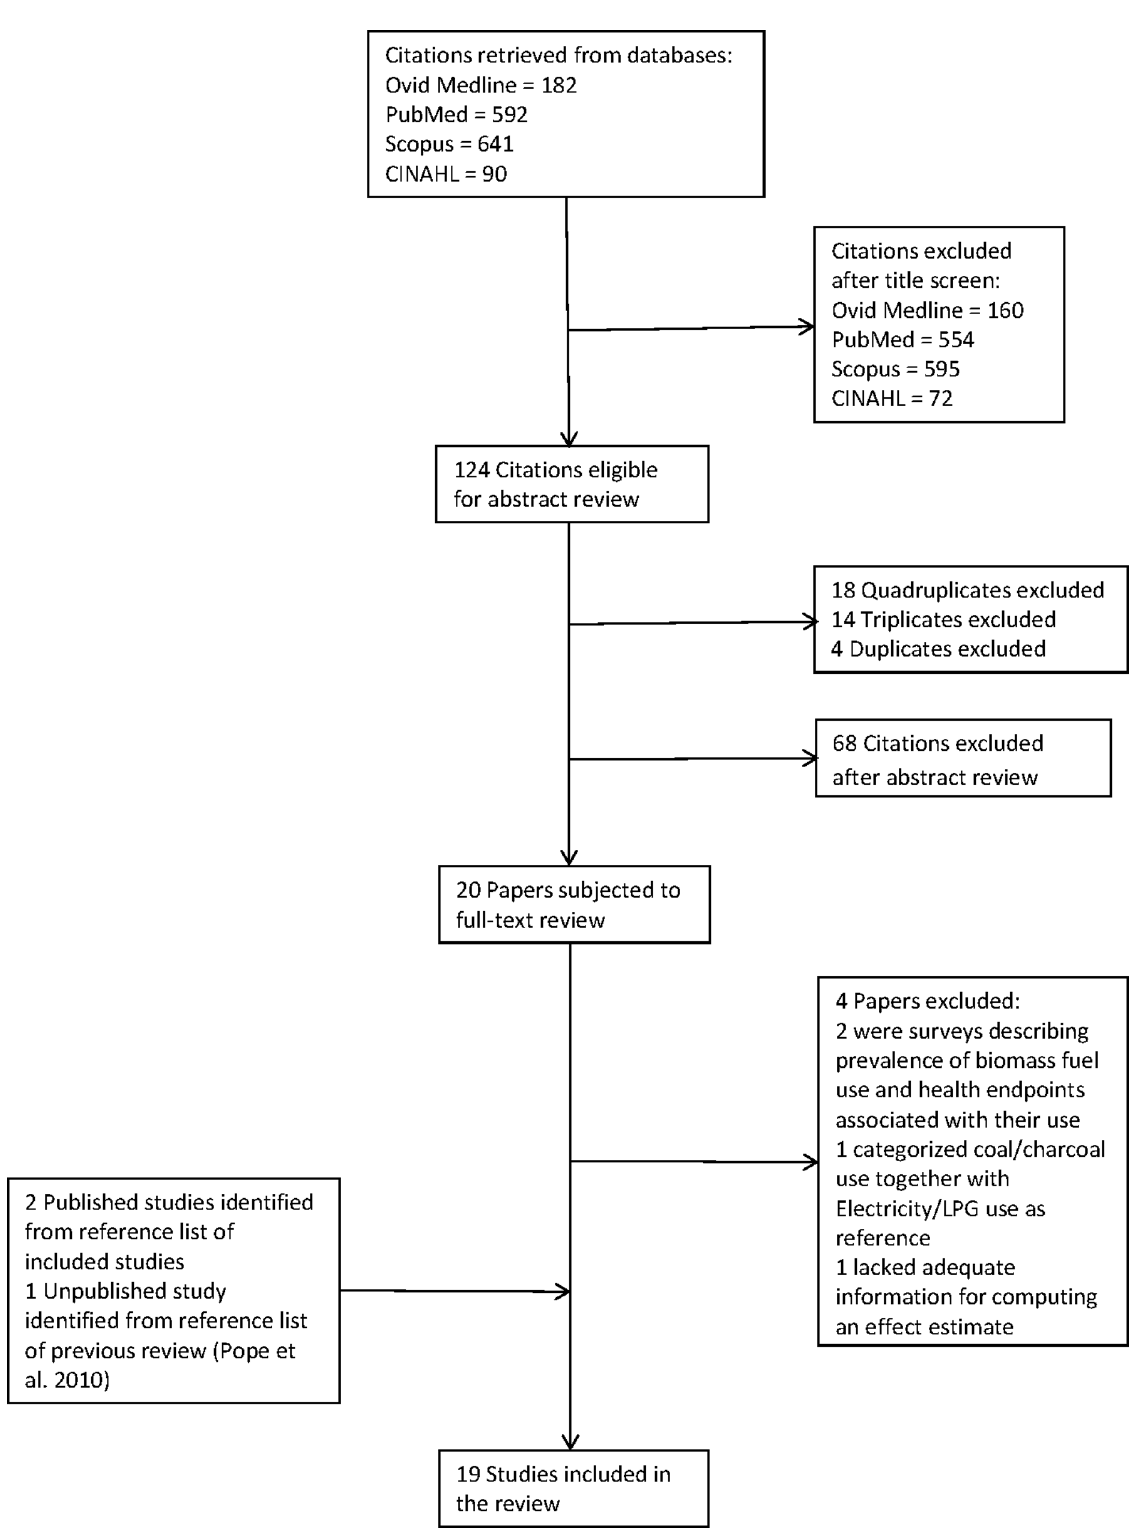
Figure 1. Flowchart of search strategy and selection of studies for inclusion in review. doi:10.1371/journal.pone.0113920.g001 PLOS ONE | DOI:10.1371/journal.pone.0113920 December 2,